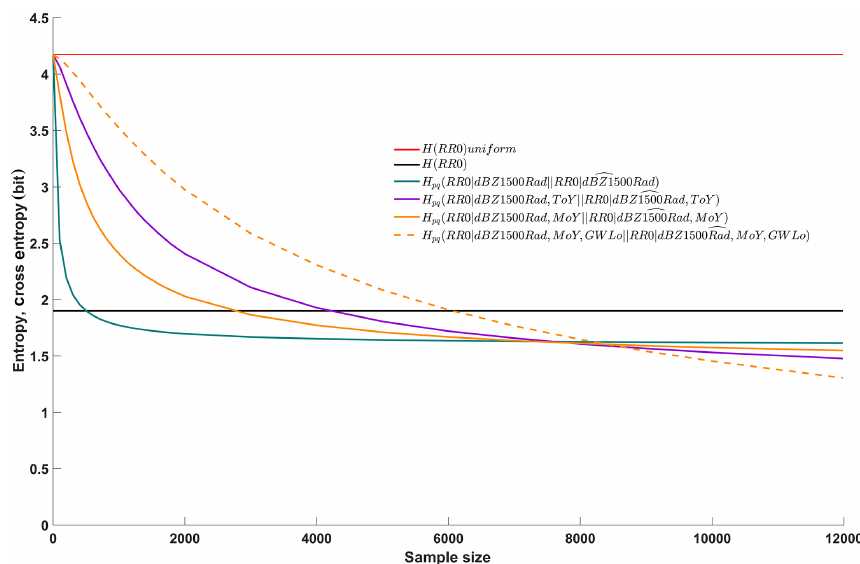
Figure 4. Entropy of the unconditional target distribution (filtered data set, black line), entropy of the benchmark uniform distribution (filtered data set, red line), cross entropies between conditional distributions of the target given one, two and three predictors of the filtered data set and samples thereof (green, purple, yellow and dashed yellow lines, respectively). The “ ∧ ” symbol indicates a